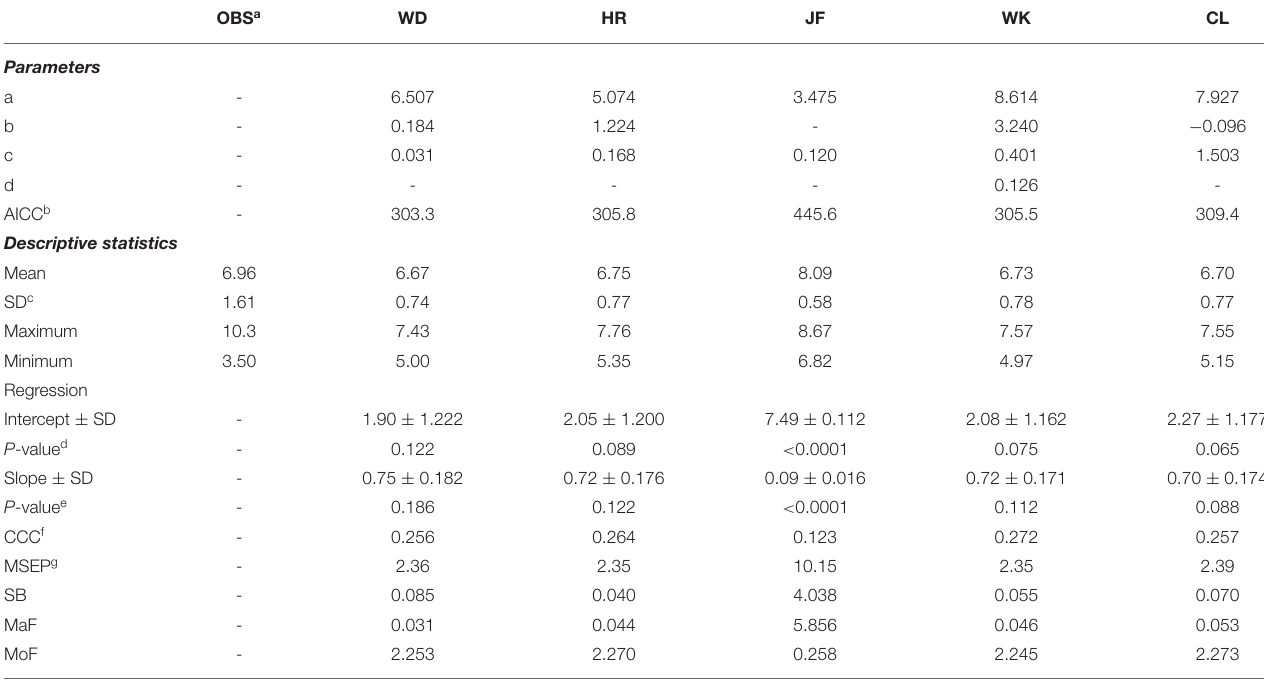
TABLE 4 | Equation parameters and descriptive statistic of the relationship between the observed and predicted values of milk production of multiparous Nellore cows under grazing. OBS a